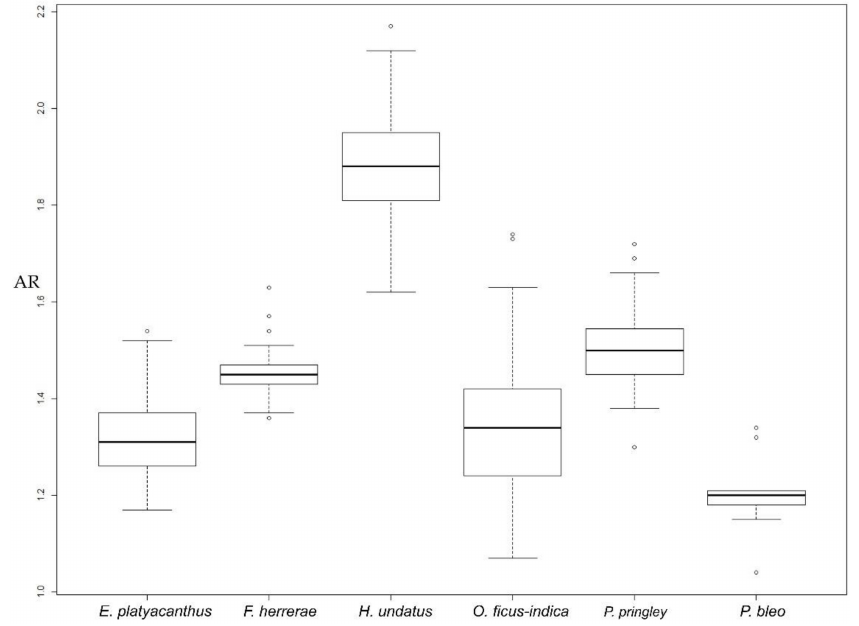
Figure A2. Values of aspect ratio for seeds of the species Echinocactus platyacanthus , Ferocactus herrerae